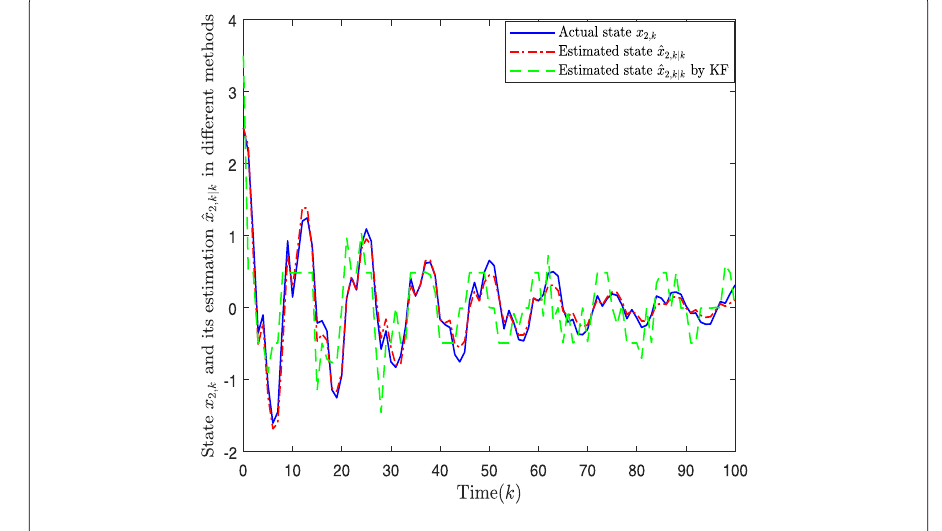
Figure 3 State x 2, k and its estimation ˆ x 2, k | k